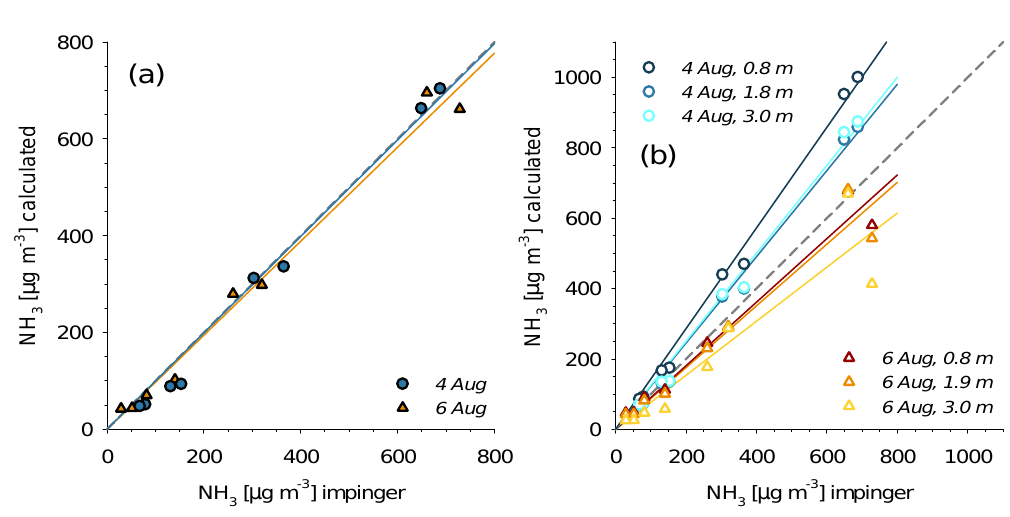
Fig. 9. Comparison of NH 3 concentrations measured by impingers and calculated with bLS, using (a) F volat , EC and (b) F volat , FTIR ; dashed lines show 1:1 relationship and solid lines depict linear regressions through zero (regression parameters see Table